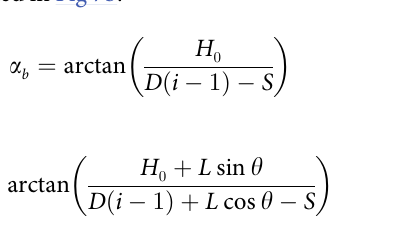
If α < ϕ , and α > ω , then that panel is the right transition panel for that ground position. t b If the top or bottom angle is obtuse, that implies that the panel edge is to the left of the ground position, then the signs are reversed relative to ω . In this case, if α > ϕ , and α < ω , then that t b panel is the left transition panel for that ground position. a and a are computed via Eq 14 t L t R when i equals the index of the left and right transition panels, respectively. With the transition panels found, the wedges labeled with d are known. The final variable to determine is the angle of wedge c , which is the angle blocked by the panel(s) between the left and right transition panels (termed the “panel angle” in Fig 5). The last consideration is the edge effects for ground positions underneath the leftmost or rightmost panel in the array. The relative magnitudes of the critical angles and the edge angles are used to identify edge cases. At the left edge of the array, the left edge angle is less than the left critical angle. Here, one shade wedge is eliminated (Fig 6b). The same applies for the right edge case, when the right edge angle is greater than the right critical angle. The viewfactor, F , is computed for positions S 2 (0, D ( N − 1)) in Eq 11. v